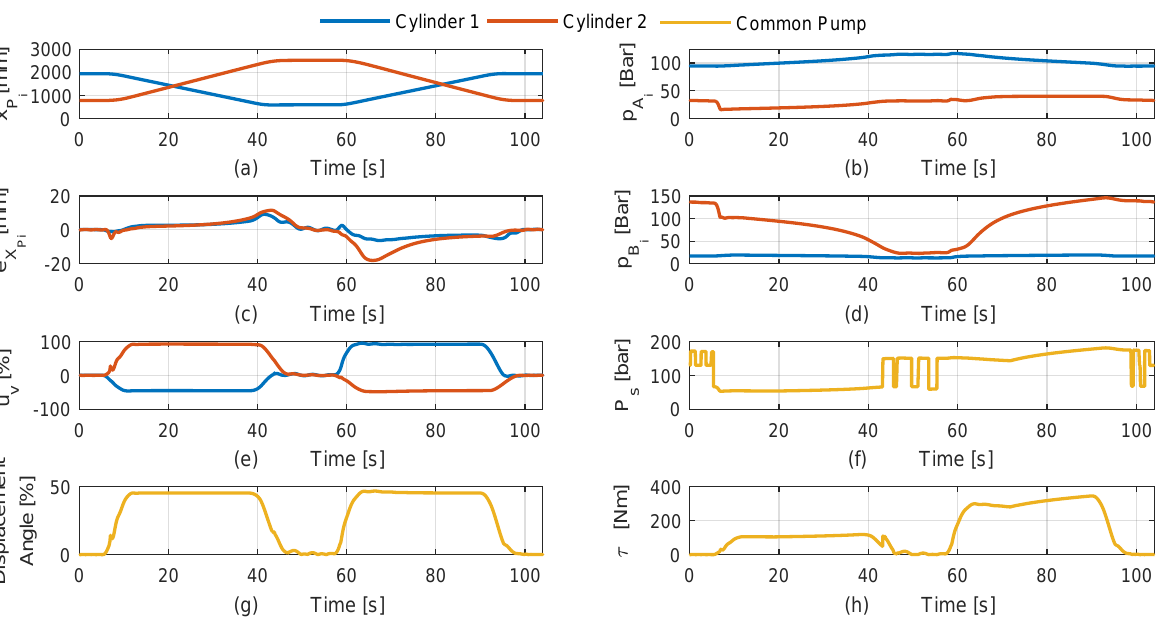
Figure 13: Performance results for the Valve Cylinder Drives